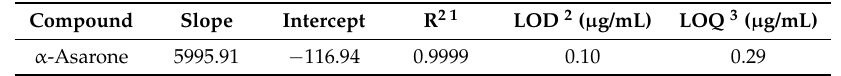
Table 1. Statistical analysis for the calibration curves of α -asarone ( n = 3).